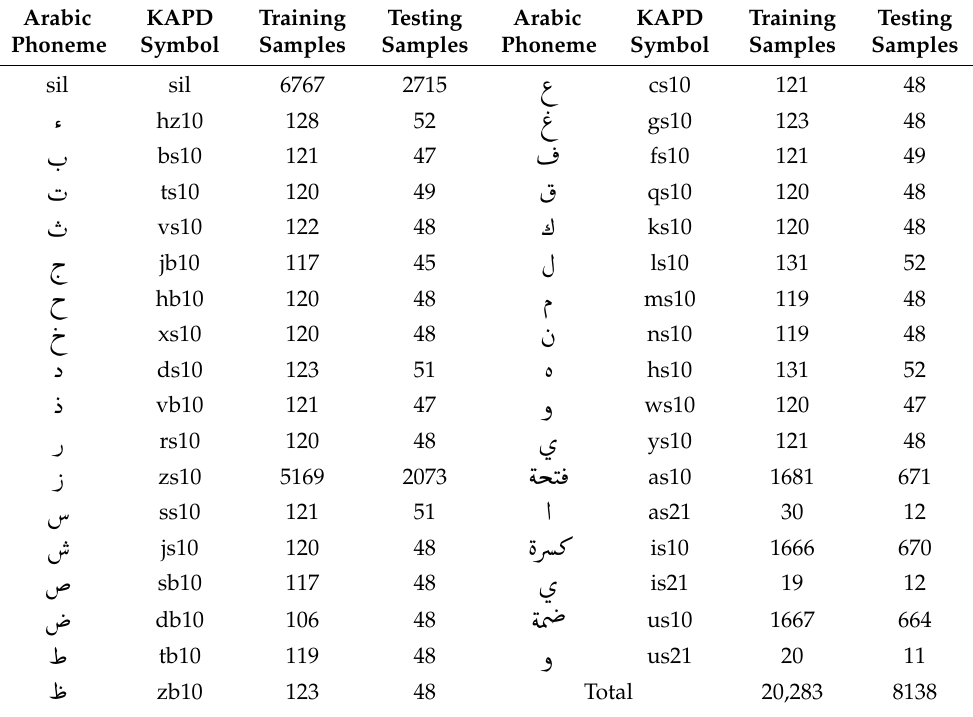
Table 2. KAPD phonemes and